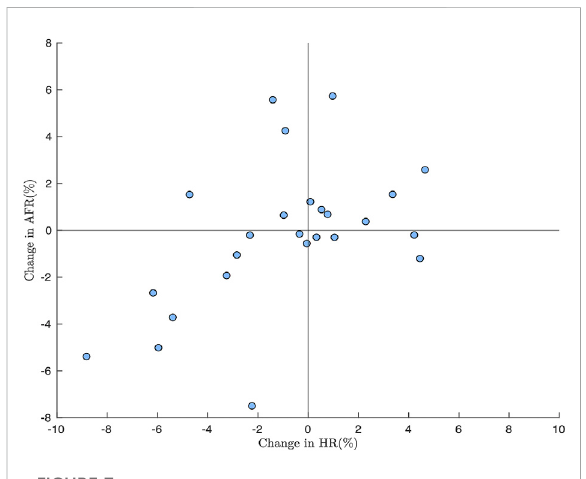
FIGURE 7 Relative changes between AFR D and AFR B plotted versus relative between HR D and HR B